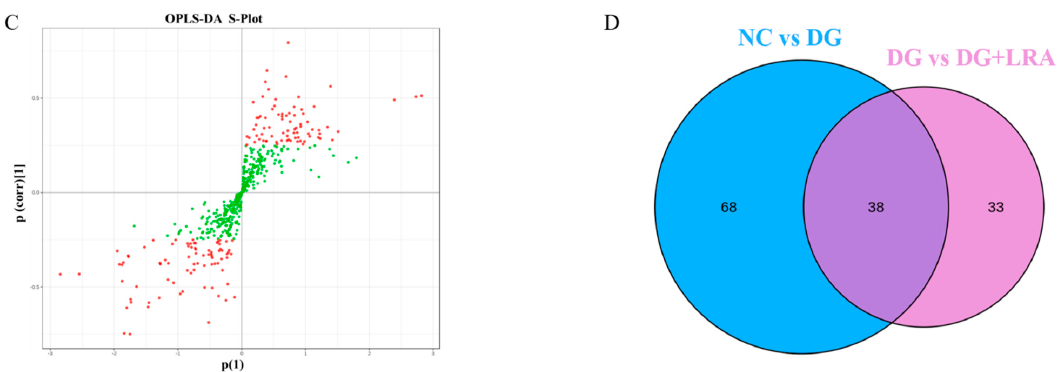
Figure 2. Influence of LRA on the serum metabolism of DG-induced aging rats ( n = 8). ( A ) 2D PCA score plot. ( B ) Scores OPLS-DA plot. ( C ) Volcano plot. ( D ) Venn diagram showing the relationship between different metabolites in each group. Red dots, VIP ≥ 1; Green dots: VIP < 1.